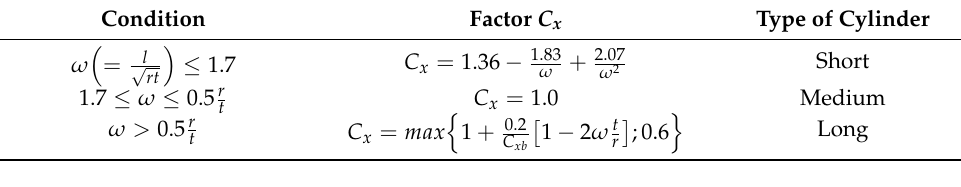
Table 1. Classification of cylinders and factor by length type [24].